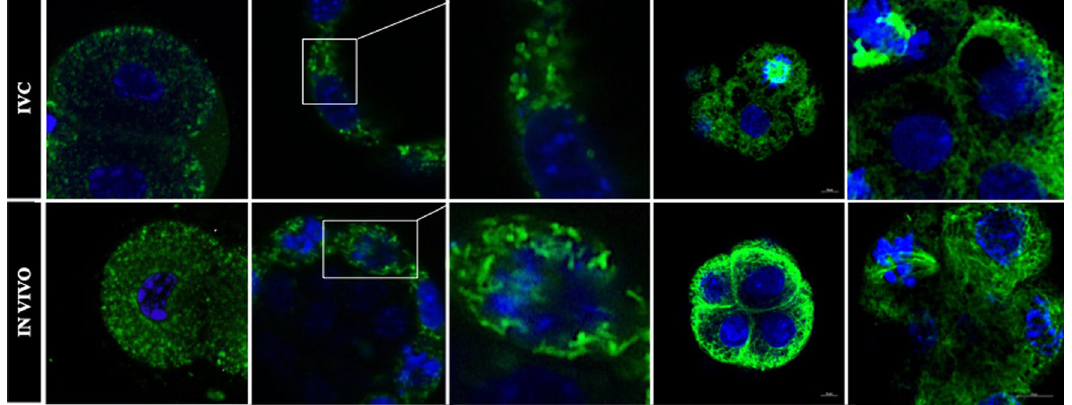
Figure 2. Mitochondrial distribution in mouse IVC (upper line) and IN VIVO developed (bottom line) 2-cell- (left column) and blastocyst (middle and right column) stage embryos. Embryos were stained with Mitotracker Green (green) for mitochondria and with Hoechst (blue) for nuclei visualization. The central column shows an enlarged of the white square from pictures of the middle columns. Scale bar: 10